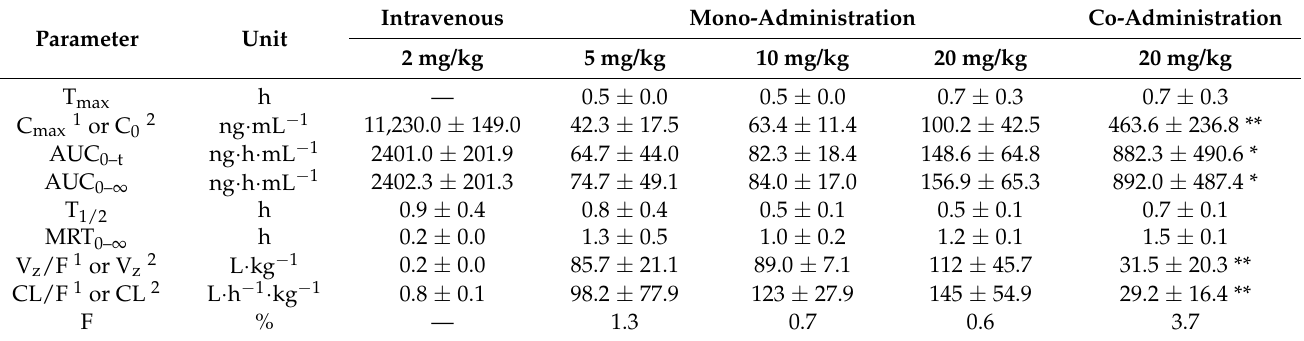
Figure 5. Mean ± SD plasma concentration-time profiles of PF after administration (5, 10, 20 mg/kg) in SD Rat ( A ); Mean ± SD plasma concentration-time profiles of PF after mono- and co-administration in SD Rat ( B ). Table 8. Pharmacokinetic parameters of PF in rat plasma after intravenous administration (2 mg/kg), oral mono-administration (5, 10 and 20 mg/kg) and co-administration with verapamil ( n = 5).